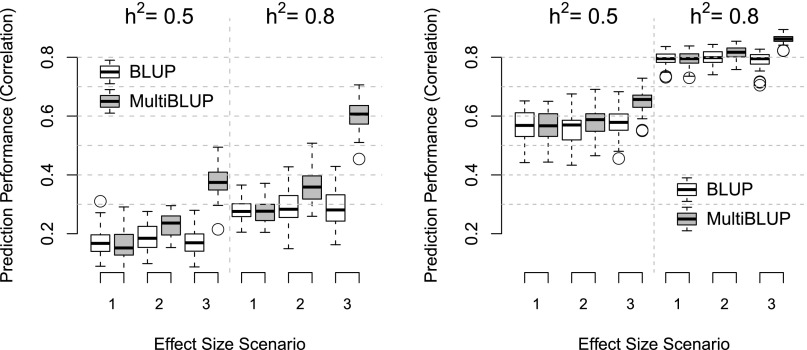
Prediction performance of BLUP and MultiBLUP on simulated quantitative traits. The two plots correspond to unrelated humans (left) and related mice (right). They show across 50 repetitions the correlation between predicted and observed phenotypes in the test set for BLUP (white boxes) and MultiBLUP (shaded boxes). The x-axis indexes the simulation scenarios, with increasing heterogeneity of effect sizes across the five regions. Here, MultiBLUP uses five GSMs, one for each region. Within each plot, the true (simulated) heritability is 0.5 (left half) or 0.8 (right half).